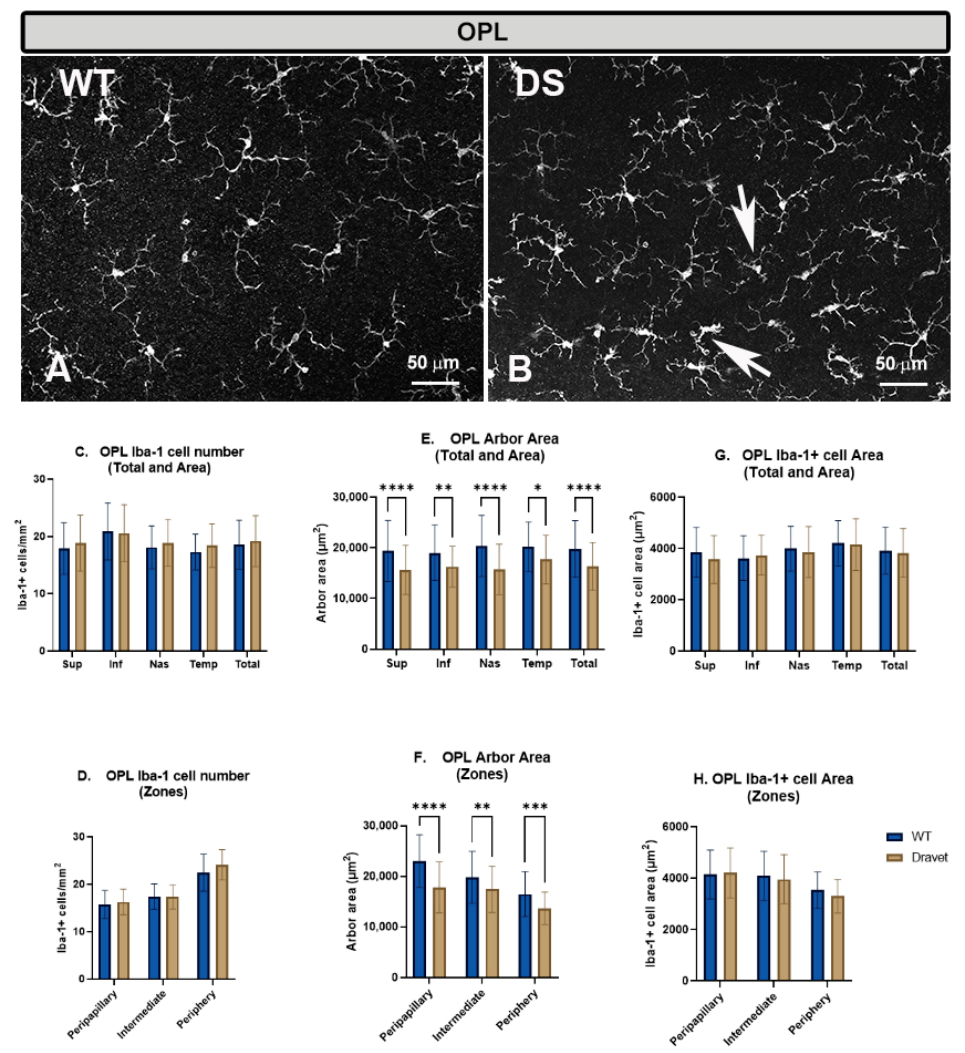
Figure 1. Microglial cells in the outer plexiform layer (OPL). ( A , B ): retinal whole-mounts labeled with anti-Iba-1 at 20× magnification. Arrows indicate Iba-1+ microglial cells with retraction of the processes in the Dravet syndrome (DS) animals. ( C , D ): number of Iba-1+ microglial cells per retinal area 0.1502 mm 2 by total retina and area € and by zone ( D ). ( E , F ): Arbor area of Iba-1+ microglia by total retina and area ( E ) and by zone ( F ). ( G , H ): Iba-1+ cell area by total retina and area ( G ) and by zone ( H ). Two-way ANOVA. Data expressed as mean value ( ± SD). * p < 0.05, ** p < 0.01, *** p < 0.001, **** p < 0.0001. Number of retinas used in the experiment: WT animals n = 6, DS animals n = 6. Sup: superior; Inf: inferior; Nas: nasal; Temp: temporal.